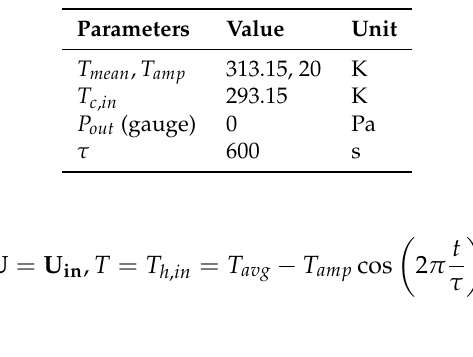
Table 4. Base case boundary conditions and